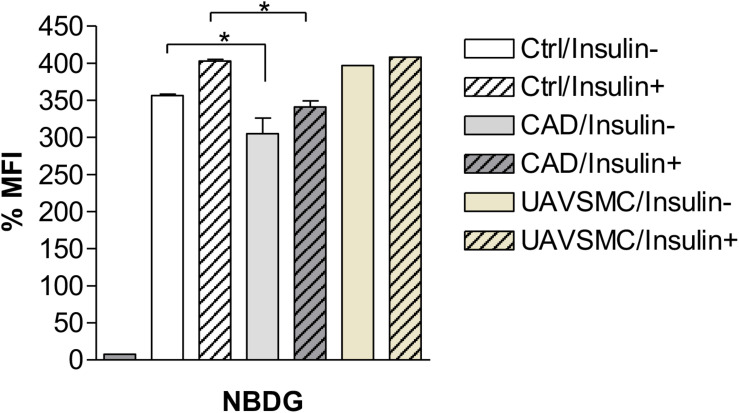
Effects of Insulin on Glucose uptake in CADASIL VSMCs. The VSMCs (CADASIL, control and UAVSMCs) were cultured and 200 μM 2-NBDG; a fluorescent indicator for monitoring glucose uptake, was added to the cells (M&M), incubated with and without 50 mM insulin. The 2-NBDG uptake was measured by flow cytometry. Flow cytometry analysis showed a reduced glucose uptake before addition of insulin in CADASIL VSMCs (*p < 0.05), however, lower glucose uptake was not affected by insulin in CADASIL VSMCs. Ctrl: control VSMC, CAD: CADASIL, MFI: mean fluorescence intensity, UAVSMC: Umbilical artery smooth muscle cells.